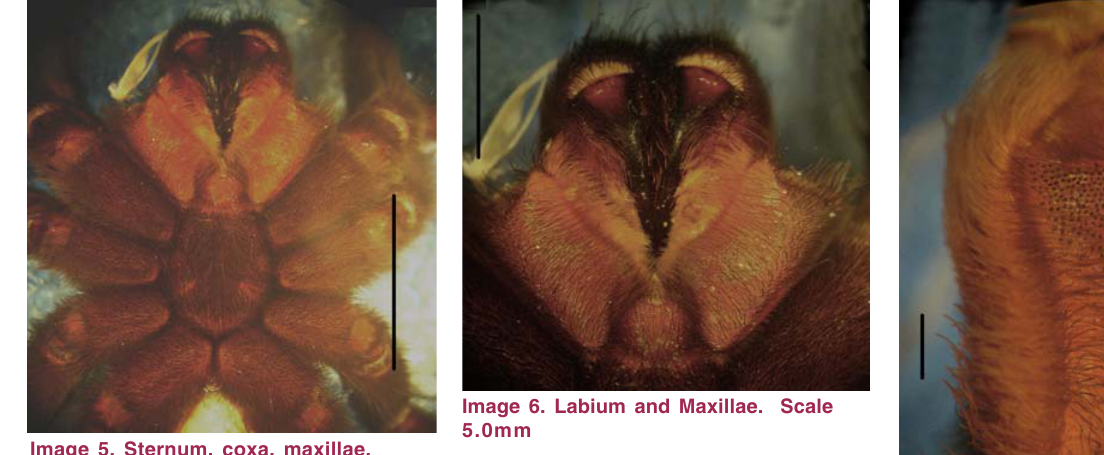
Image 6. Labium and Maxillae. Scale 5.0mm